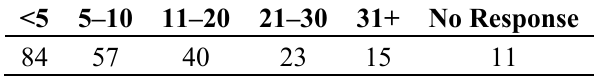
Table 2. Years in field distribution of